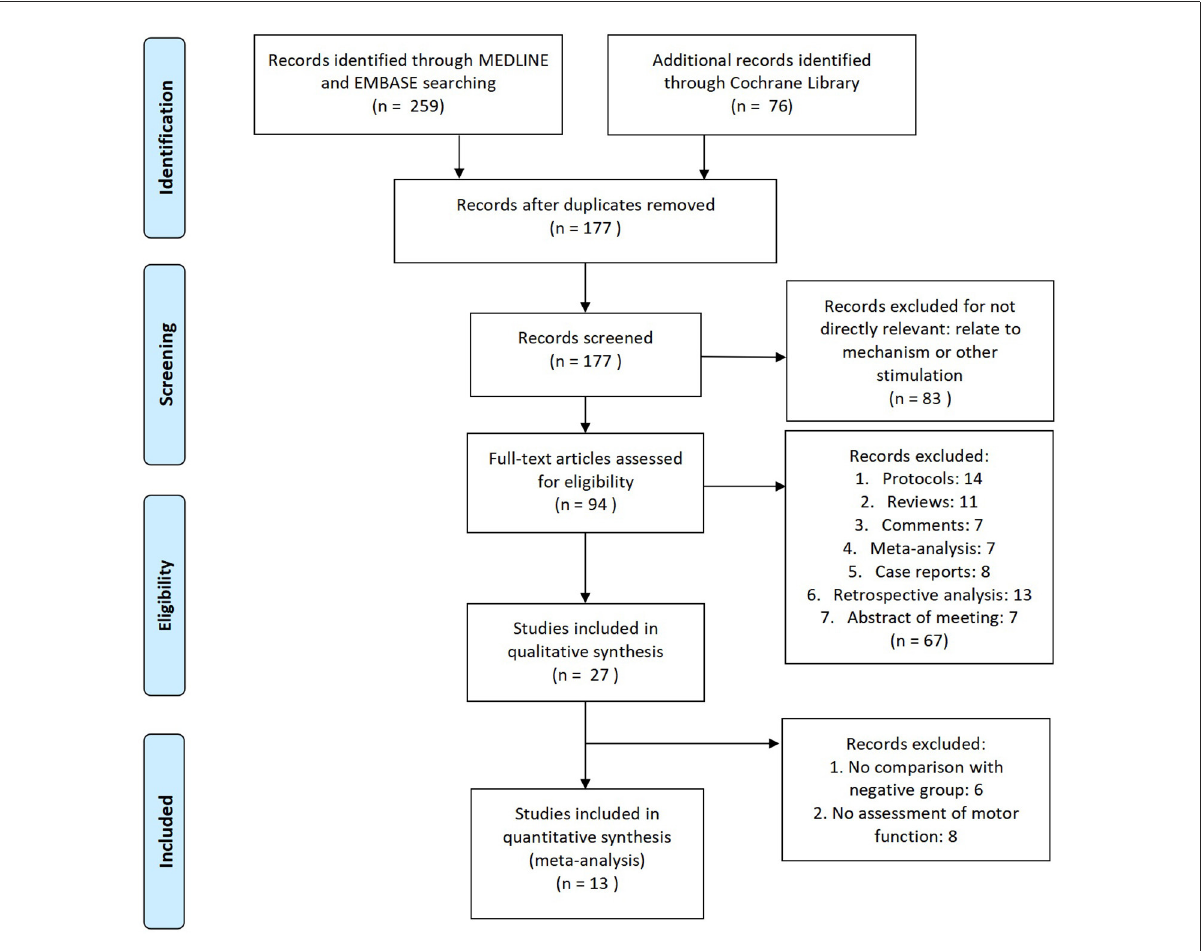
FIGURE1 The study search, selection, and inclusion process.